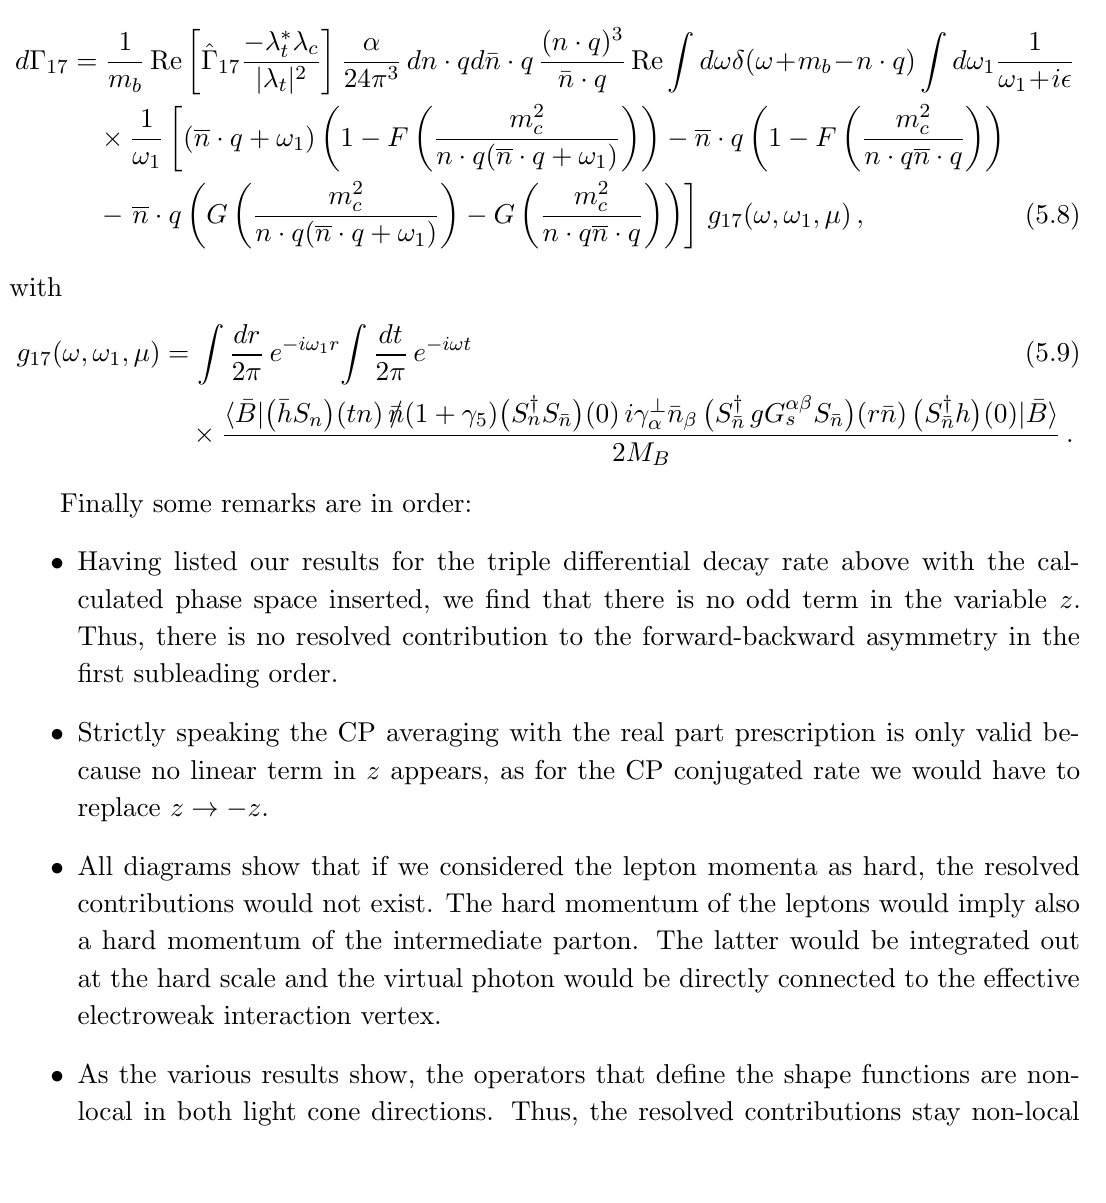
Figure 8 . The cut diagram arising from the matching of the (left) and onto HQET (right). Red indicates soft (cid:12)elds, black (anti-) hard-collinear (cid:12)elds. Hard (cid:12)elds are already integrated out. Dashed lines correspond to non-localities. The decomposition of the Lorentz structure has been done above (see section